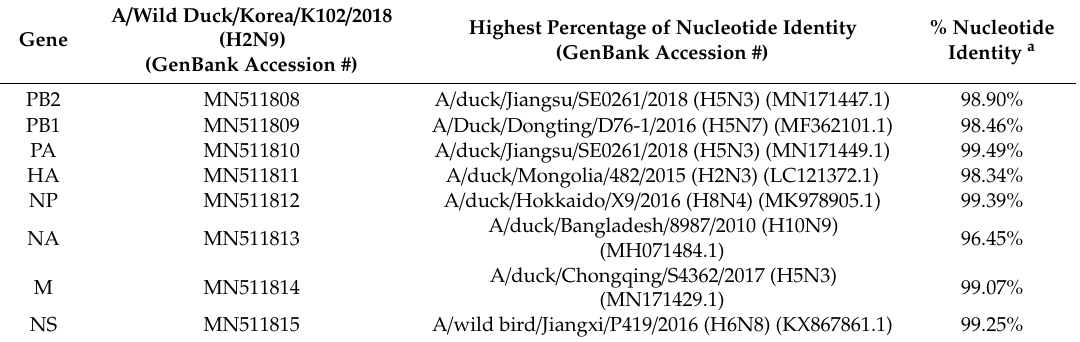
Table 2. Sequence homology of the whole genome of the A/wild duck/Korea/K102/2018 (H2N9) avian influenza virus (AIV) compared to influenza sequences available in NCBI.